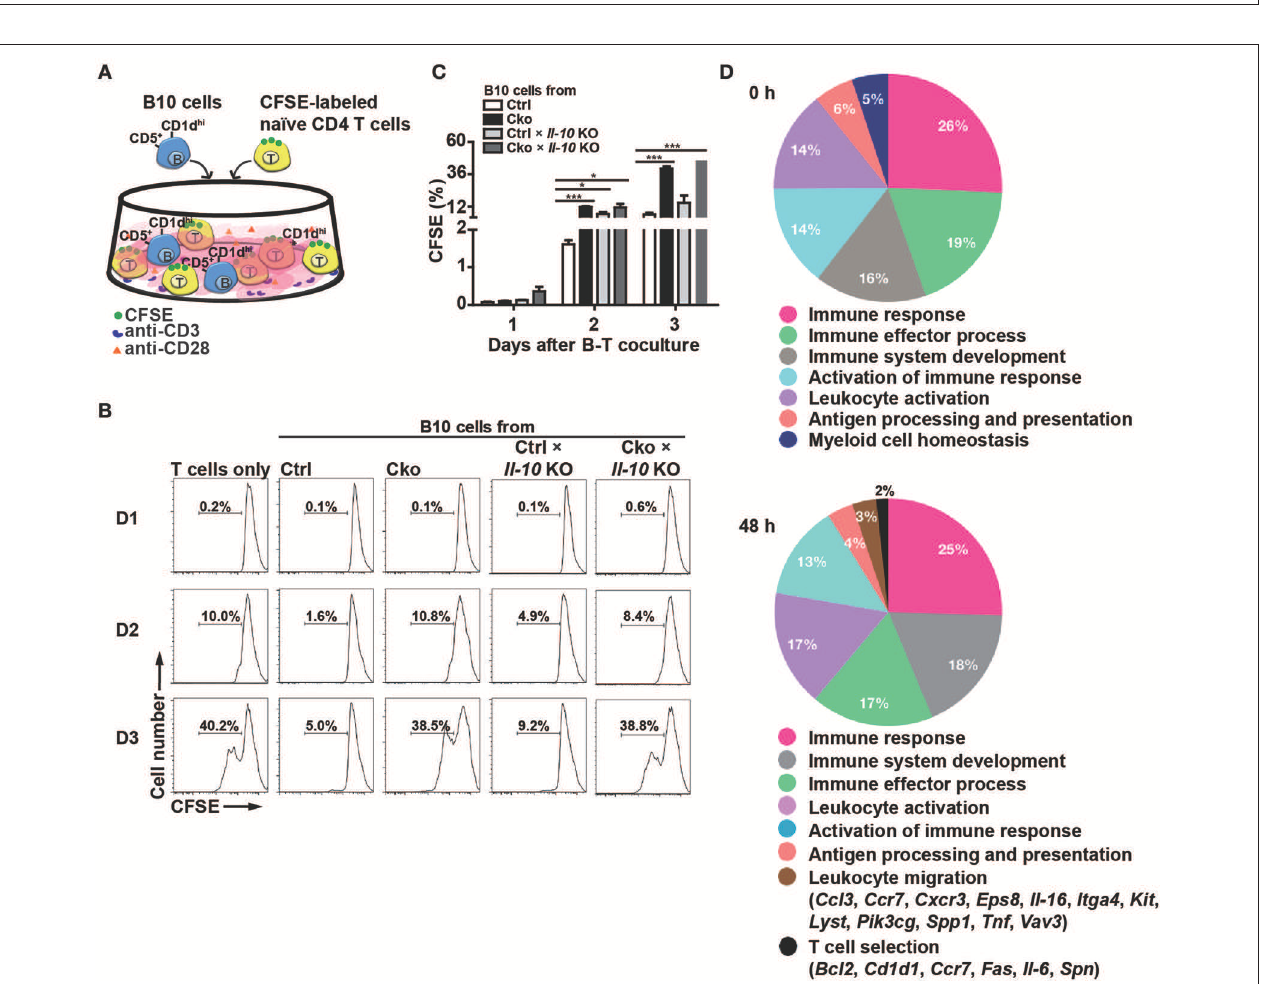
FIGURE 3 | B10 cells lacking Blimp-1 failed to suppress T-cell proliferation. (A) Experimental design for the co-culture of B10 cells with anti-CD3-and anti-CD28-stimulated naïve CD4 + T cells. CFSE-labeled CD4 + T cells in the presence of anti-CD3 and anti-CD28 antibody were co-cultured with B10 cells from mice of the indicated genotypes for 3 days and then analyzed for CFSE dilution by FACS. (B) FACS analysis showing the frequency of dividing CFSE-labeled CD4 + T cells. Data are representative from three independent biological replicates. (C) Statistical results from three experiments in (B) are shown. Data were analyzed using an unpaired Student’s t -test and are the mean ± SEM ( n = 3 mice per group). * p < 0.05 and *** p < 0.001. (D) GO analysis showed a significant enrichment for genes in “T cell selection” and “leukocyte migration” in the category of immune system process within the Biological Process ontology in anti-CD40 stimulated Cko B10 cells as compared with genes in anti-CD40 stimulated Ctrl B10 cells. The significant terms in the immune system process within the Biological Process ontology were all listed.